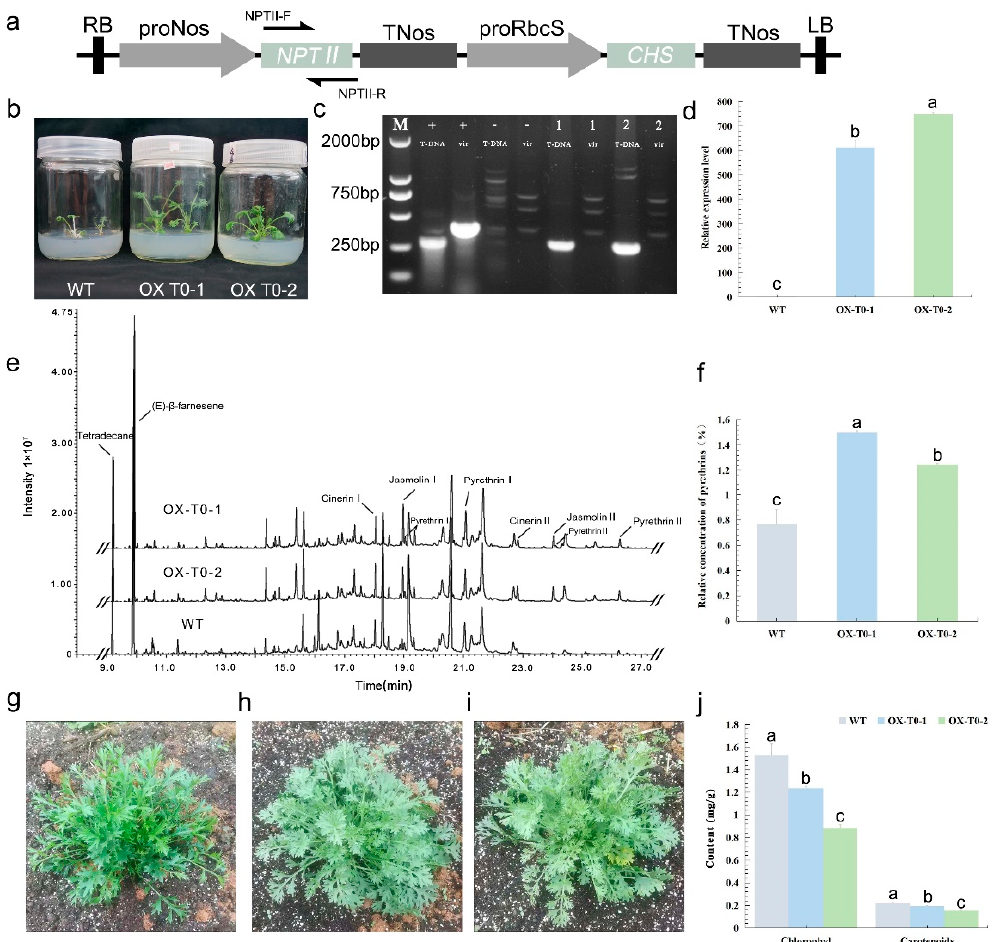
Figure 4. Analysis of transgenic proRbcS-TcCHS pyrethrum plants. ( a ) Schematic structure of proRbcS-TcCHS vector and primer locations (arrows). ( b ) OX T0-1 and OX T0-2 seedlings were screened